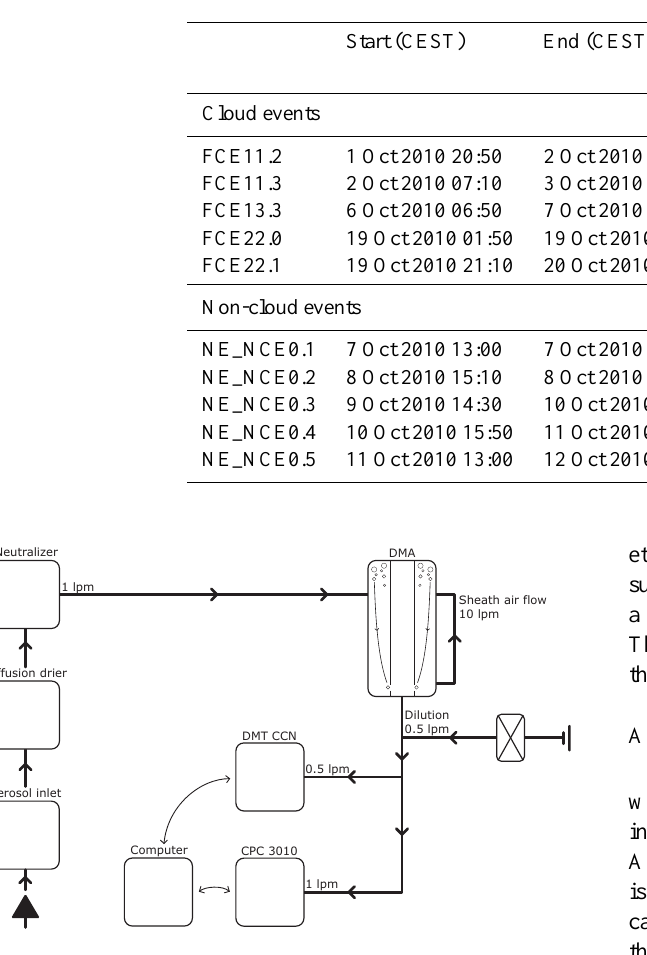
Fig. 2. Set-up for the size segregated CCN measurements. The experimental set-up was identical for the up- Figure 2. Setup for the size-segregated CCN measurements. The and downwind sites. experimental setup was identical for the upwind and downwind